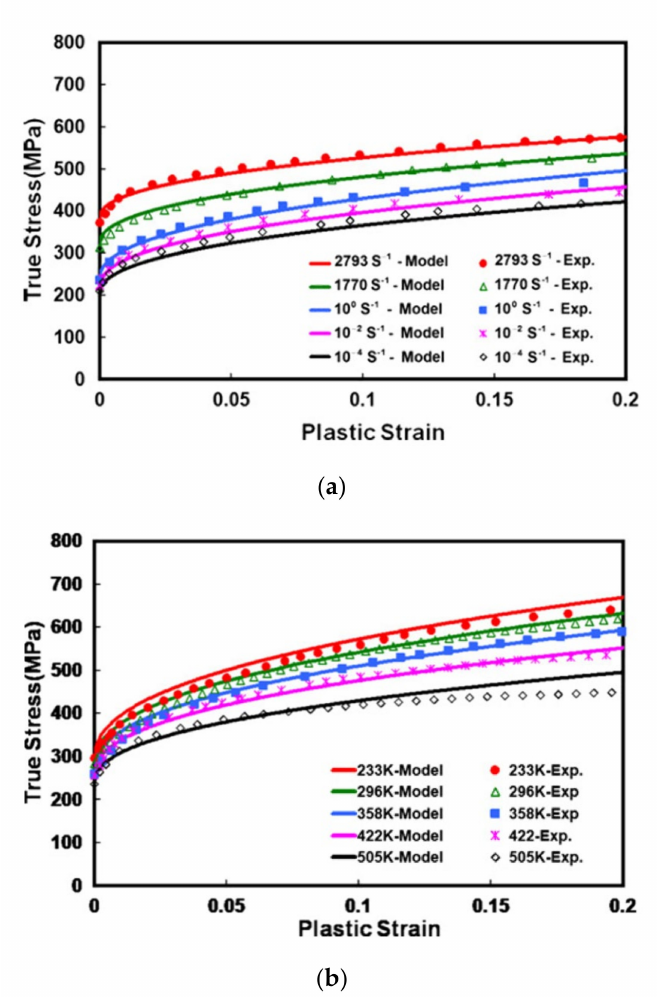
Figure 17. Experimental (symbols) and computed (solid lines) stress–strain curves of AA2024-T351 from uniaxial compression tests at ( a ) a temperature of 232 ◦ C with di ff erent strain rates, and ( b ) a strain rate of 10 s − 1 at di ff erent temperatures (Reproduced with permission from Elsevier